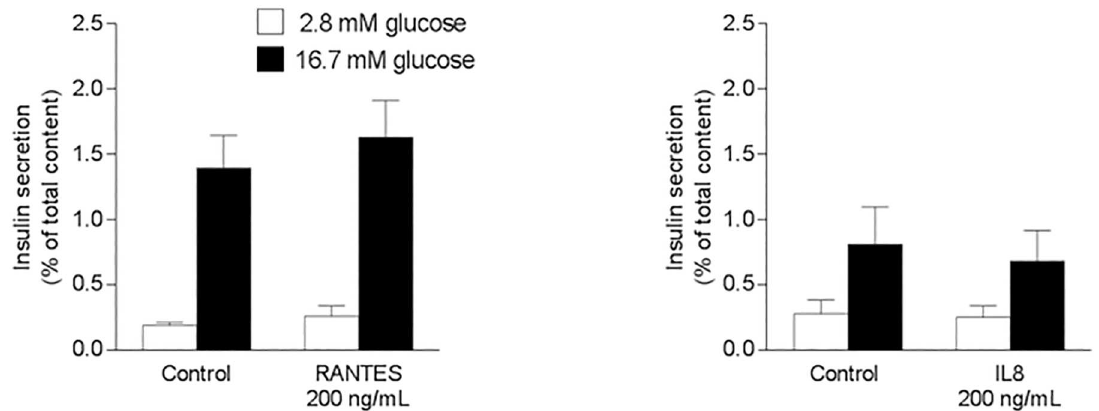
Fig 5. Glucose-stimulated insulin secretion in isolated mice islets incubated with recombinant RANTES or IL8. Glucose-stimulatedinsulinsecretionin isolated pancreatic islets after incubation for 24 h with/without200 ng/mL RANTES/ CCL5(A) or IL8 (B). n = 6–8 experiments. Mean ±